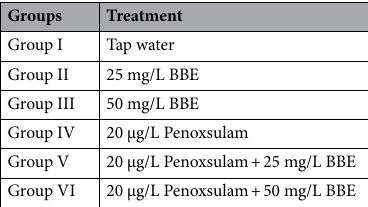
Table 1. Treatment